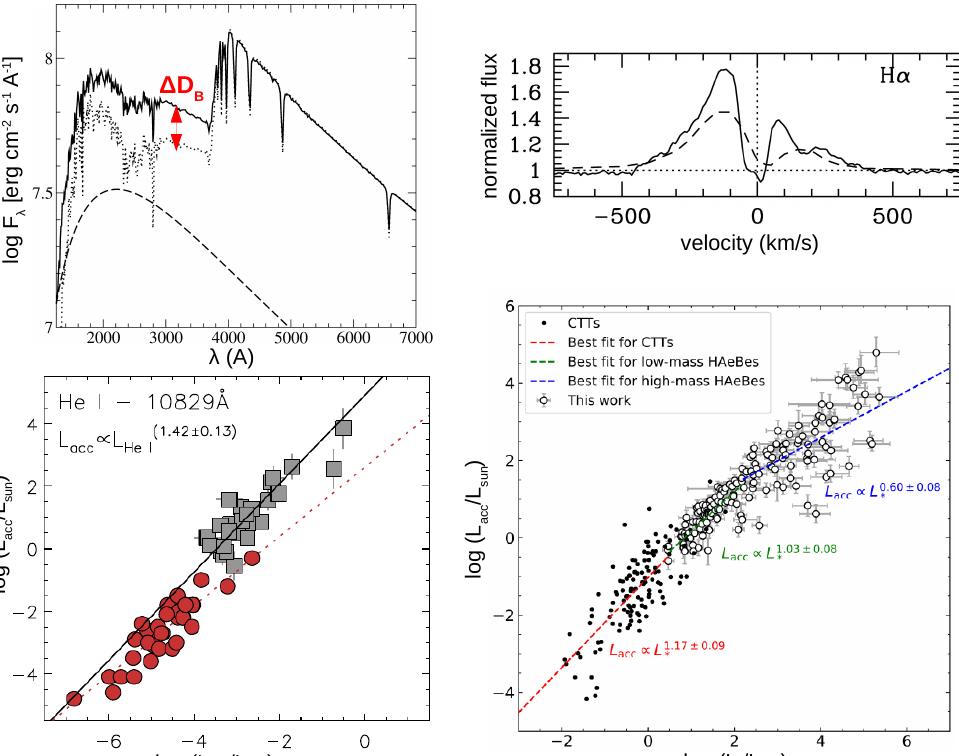
Figure 2. (Adapted from several references, as indicated next). Figure exemplifying the different methods to estimate accretion rates of HAeBe stars based on the MA scenario. ( Top left , from Mendigutía et al. (2011) [61], reproduced with permission c (cid:13) ESO.) The observed flux of a typical HAe star (solid line) shows an excess in the Balmer region of the spectrum ( ∆ D B ) compared to the corresponding flux of a naked photosphere (dotted line), which can be modeled from the sum of such photospheric flux plus the contribution of the accretion shock (dashed line). ( Top right , from Muzerolle et al. (2004) [56], c (cid:13) AAS. Reproduced with permission.) Observed line profile of the HAe star UX Ori (solid line) versus the result of MA line modeling (dashed line) dependent on several stellar, disk, and geometrical parameters. ( Bottom left , from Fairlamb et al. (2017) [64]) accretion luminosities of HAeBes (grey) versus the luminosity of the He I λ 10829 Å emission line. CTT measurements from Alcalá et al. (2014) [42] are overplotted in red. The corresponding best fits are indicated with the solid and dashed lines. ( Bottom right , from Wichittanakom et al. (2020) [66]) accretion luminosities of HAeBes (open symbols) versus stellar luminosities. CTT measurements from different references indicated in the original paper are overplotted with solid symbols. The best fits for the different regimes; CTTs, HAes, and HBes, are shown as indicated in the